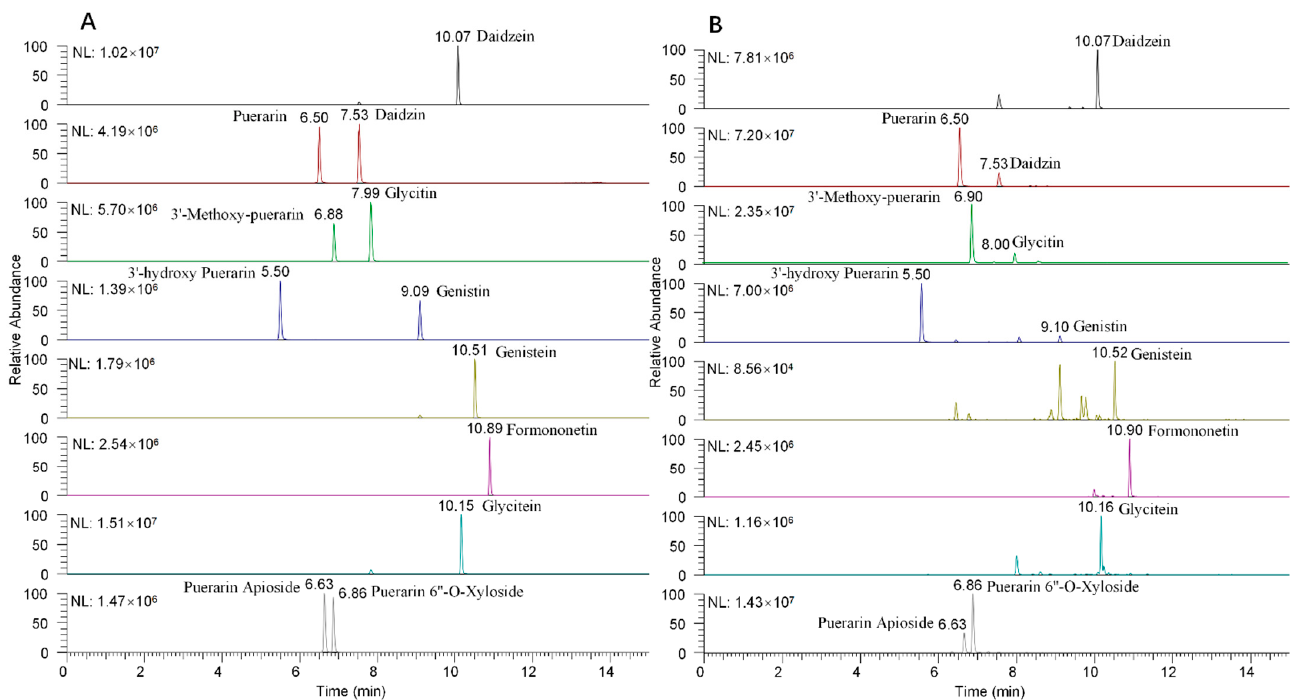
Figure 2. Extracted mass chromatograms of the 12 isoflavones in standard solution ( A ) and sample ( B ).